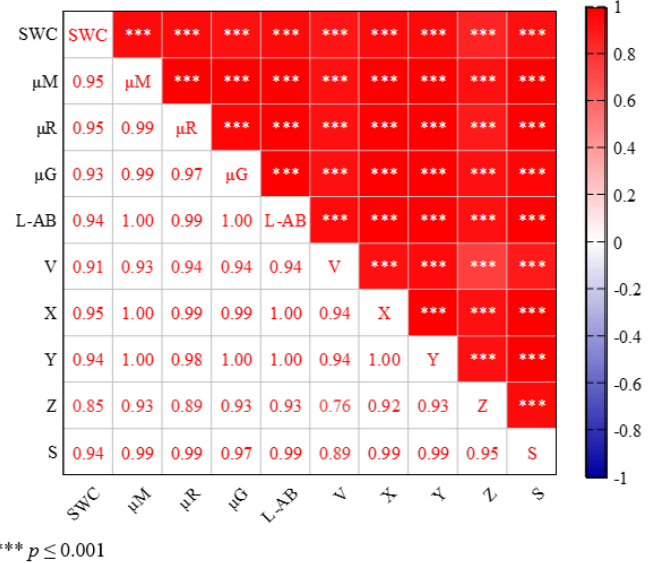
Figure 15. Correlation coefficient matrix between characteristic parameters and SWC of the rising section (*, ** and *** indicate significance at the 0.05, 0.01 and 0.001 level respectively; the colored numbers indicate the correlation coefficient between any two characteristic parameters; negative correlation is shown by the blue color, whereas positive correlation is indicated by the red color).